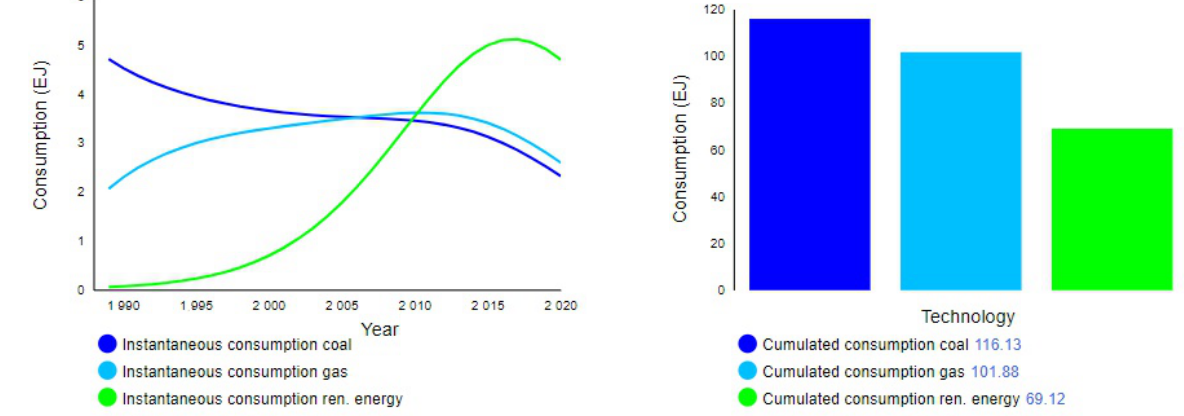
Figure 6. Simulation results of Policy